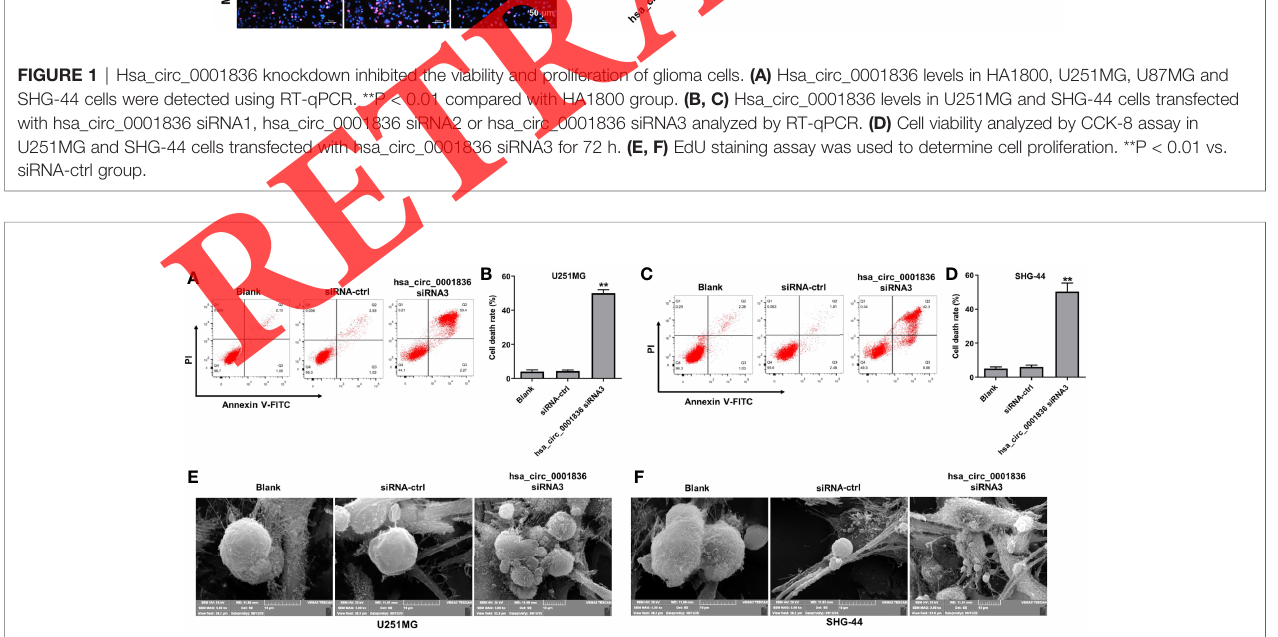
Frontiers in Oncology |